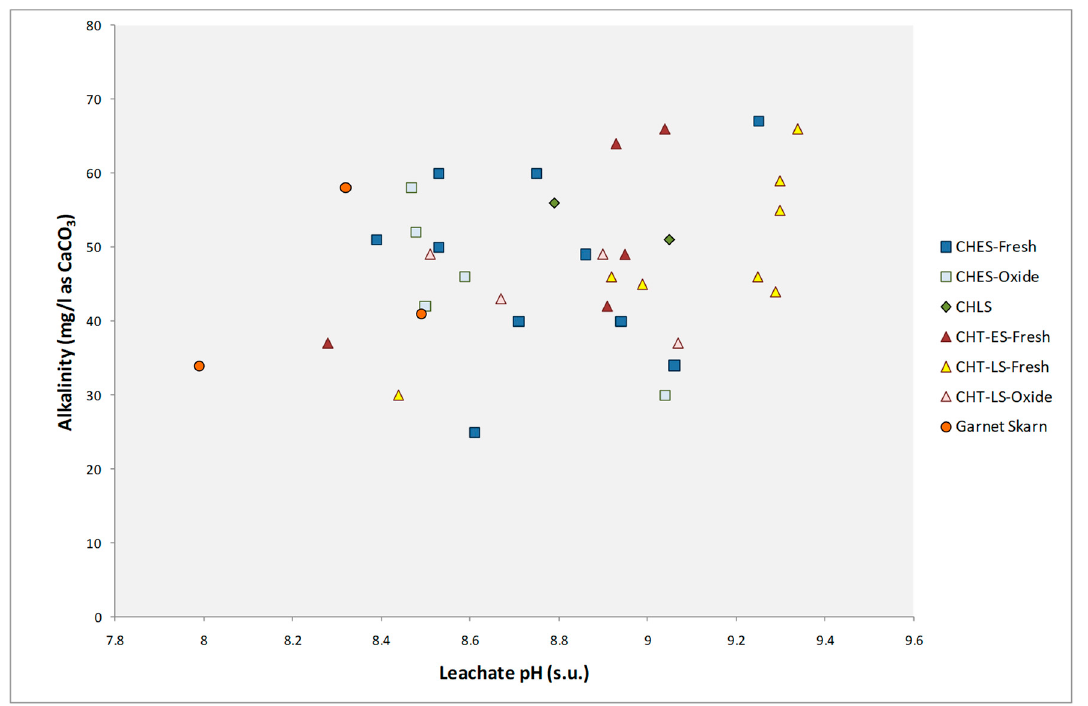
Figure 9. Relationship between leachate pH and alkalinity, deionized water leach.